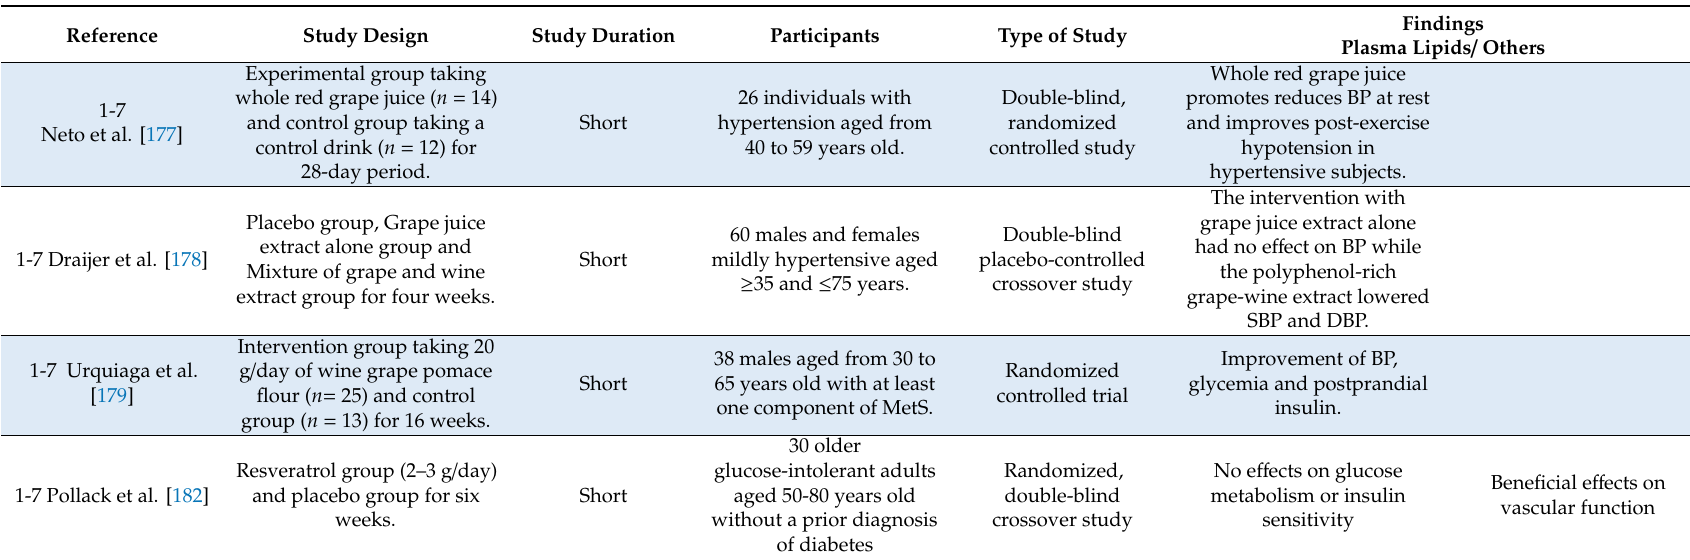
Table 7. Potential protective e ff ect of grapes or their bioactive compounds on proinflammatory and oxidative stress markers during the progression of